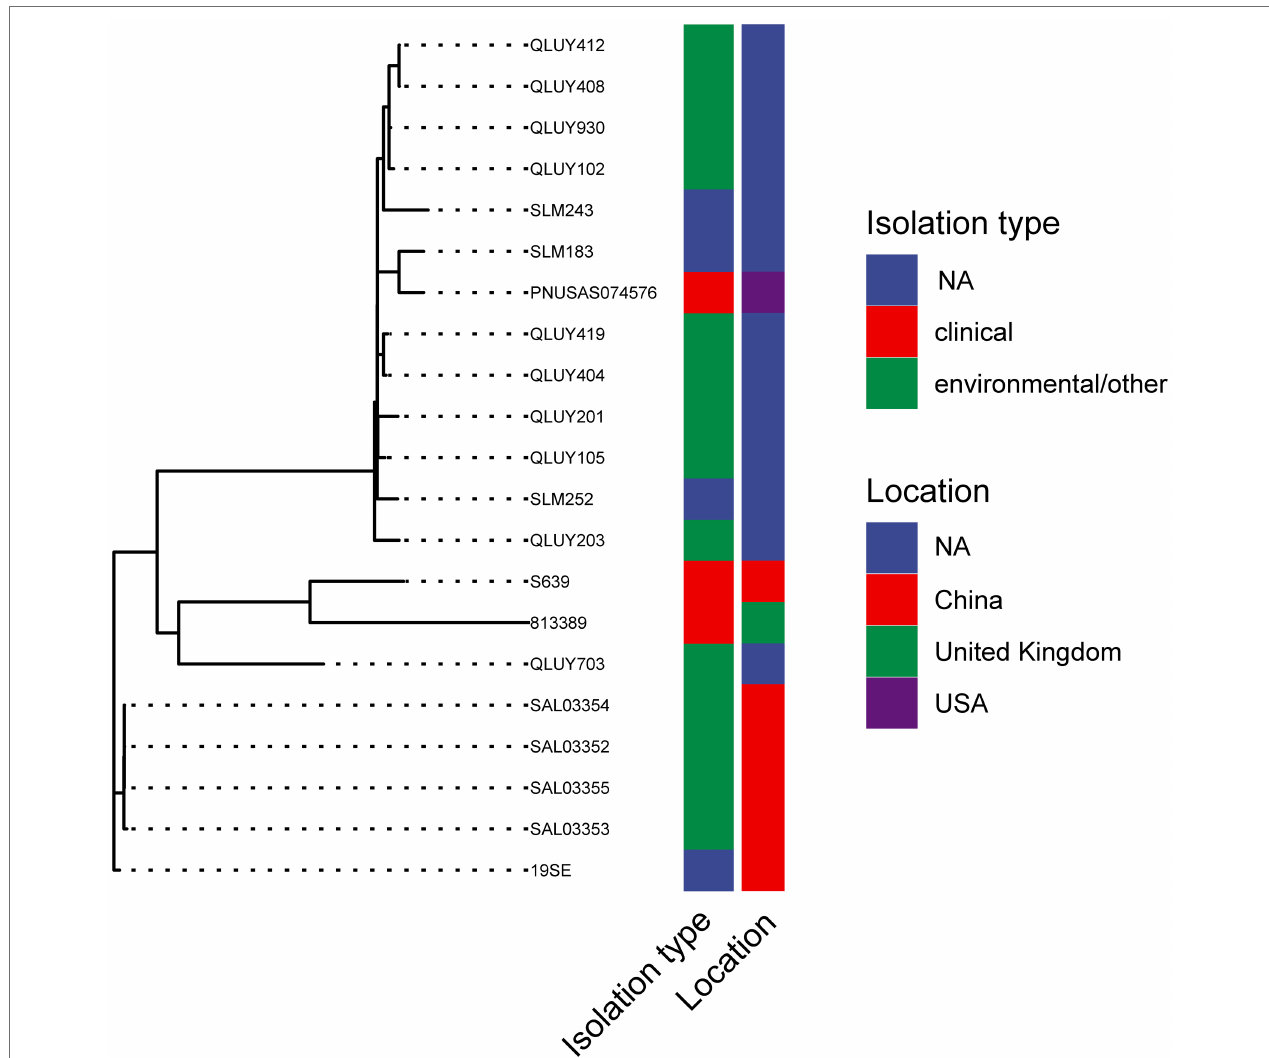
FIGURE 5 | The phylogenetic tree of mcr-9 carrying S. Thompson